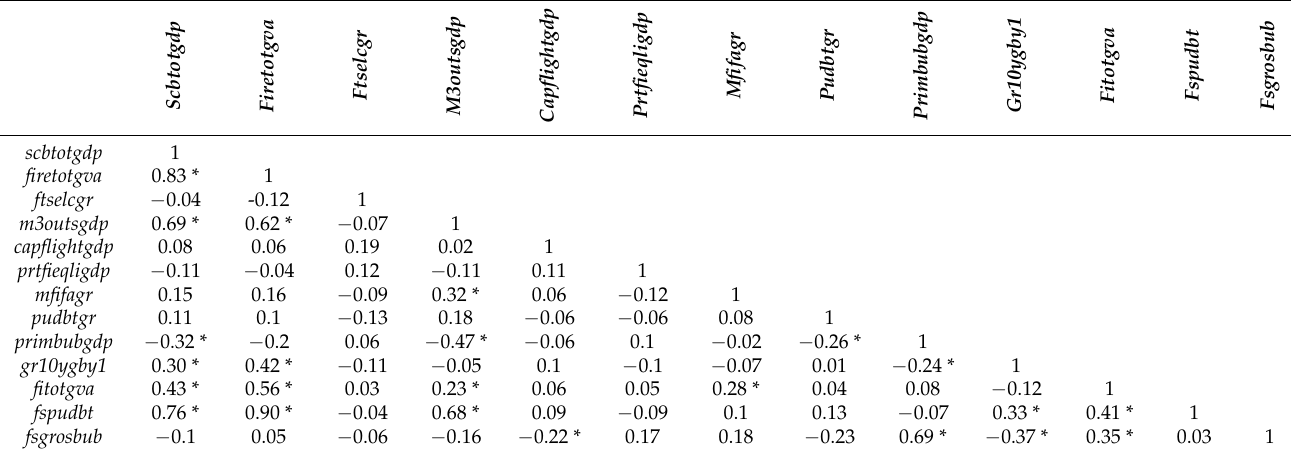
Table 2. Correlation